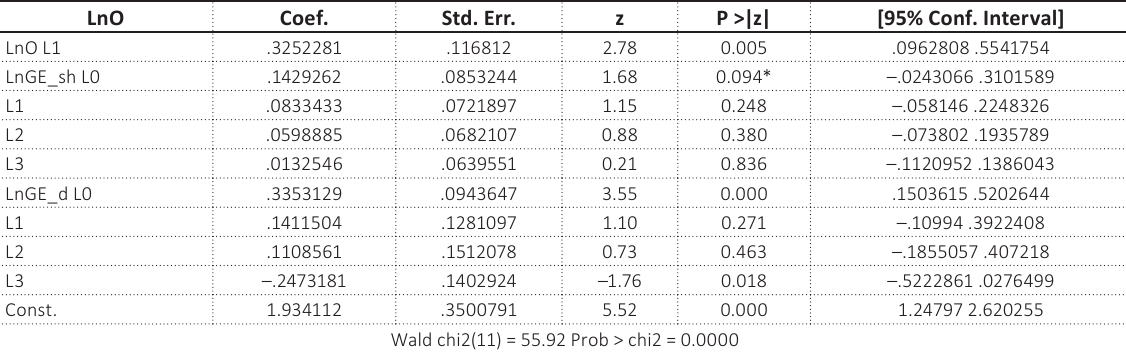
Table 3. Impact of changes in the share of government spending on housing development and housing as a direction of social protection on changes in the level of overcrowding Source: Authors’ elaboration in the STATA software